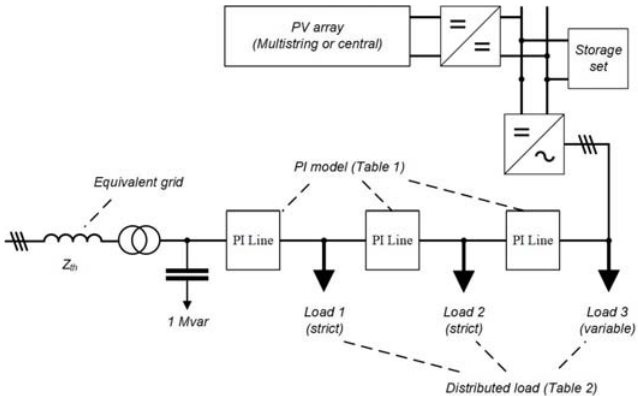
Figure 5. Simulated distribution network including MW scale PV/ESS. Table 2. Numerical data for the simulation.